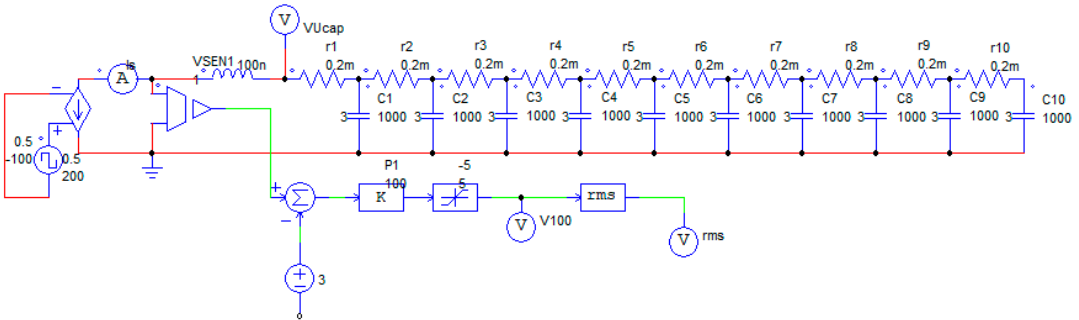
Figure 9. Model of the equivalent electrical circuit for the galvanostatic measurement. This model comprises ten r–C chains and includes the inductivity of connecting cables.